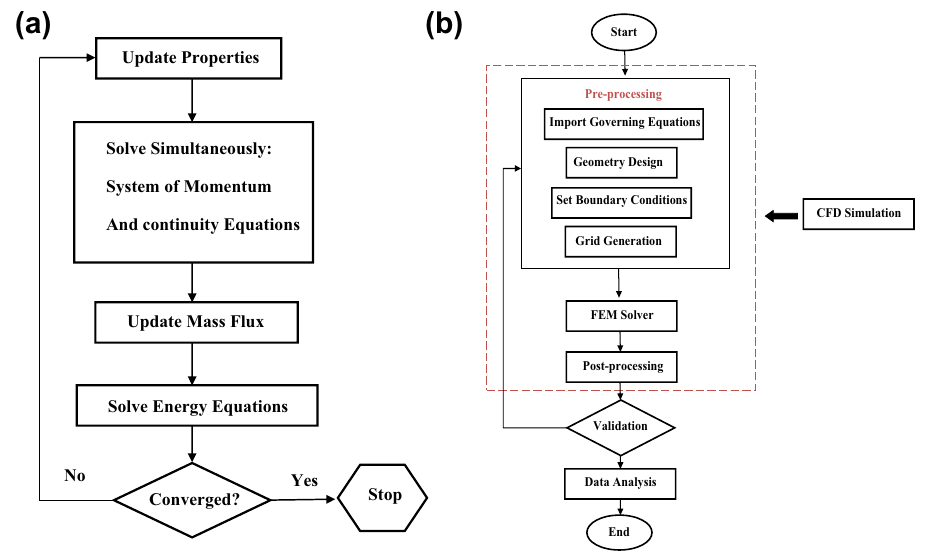
Figure 2. ( a ) The flowchart of the computational algorithm, ( b ) the flowchart of the numerical procedure.